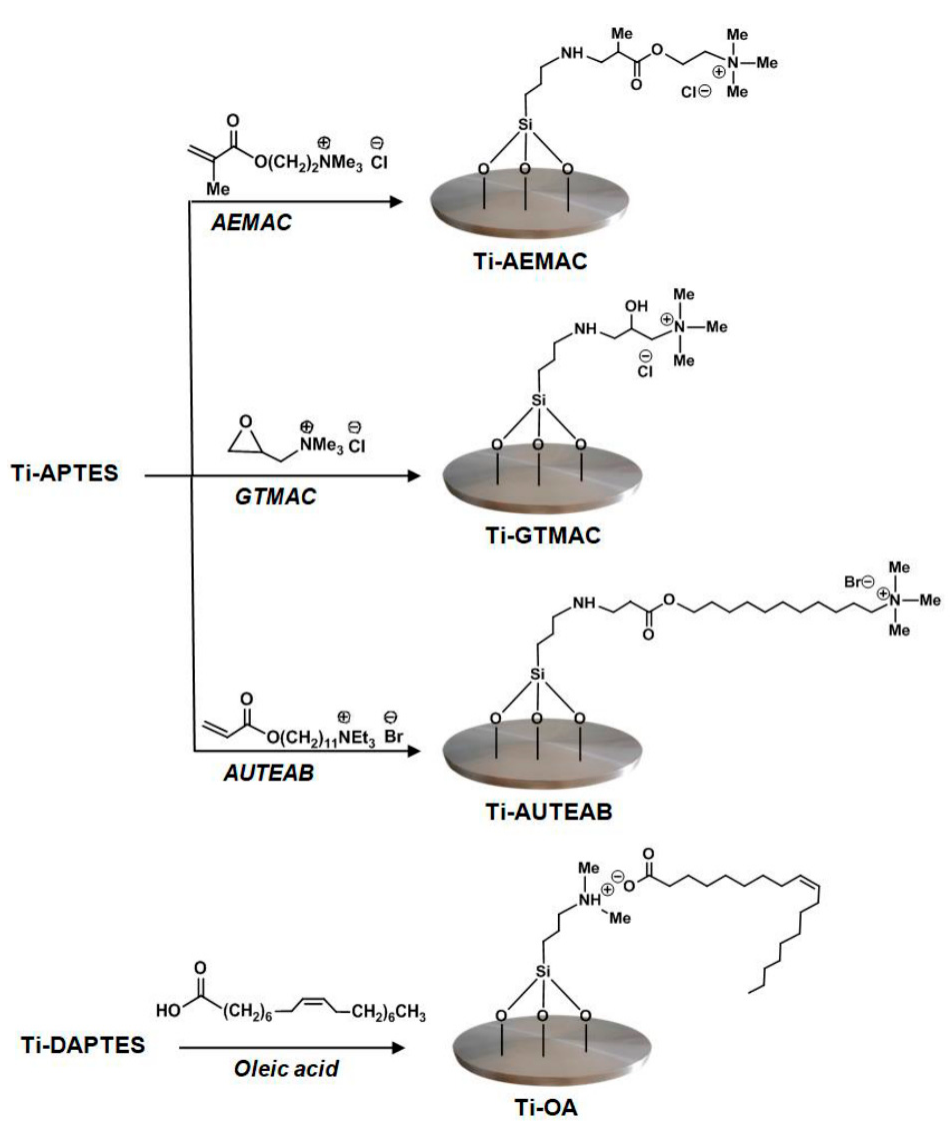
Figure 6. Diagram illustrating the synthetic pathways for functionalizing the surface of Ti. Reprinted with permission from [68]. Copyright 2021 MDPI. Distributed under Creative Commons Attribution- based license (CCBY